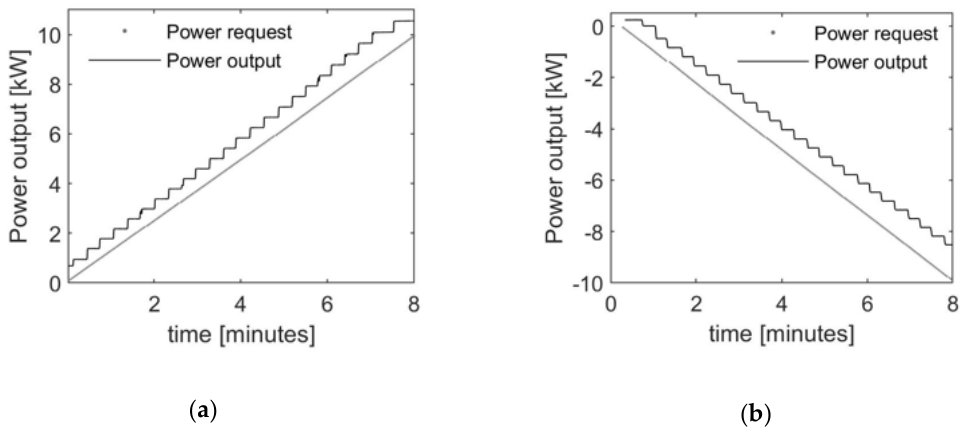
Figure 4. Comparing the requested power set points (in grey) with the effective AC power output (in black) in ( a ) charging mode; ( b ) and discharging mode. The observed steps in power output correspond to the V2G system granularity.